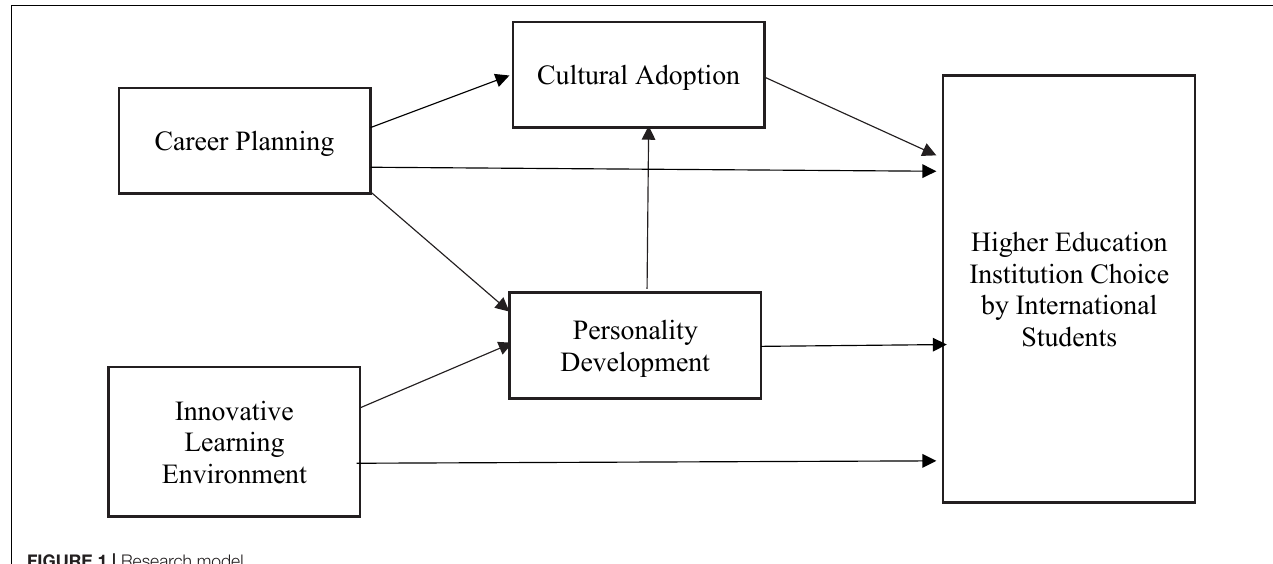
FIGURE 1 | Research